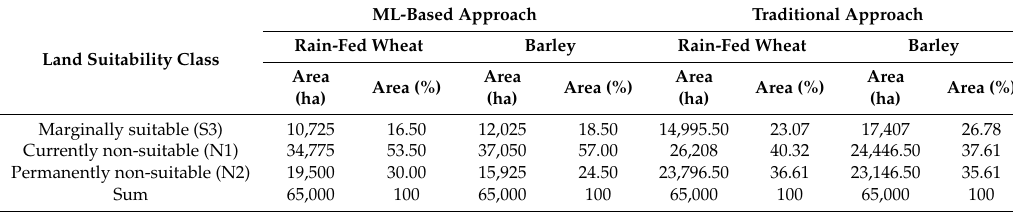
Table 4. Land suitability classes of the study